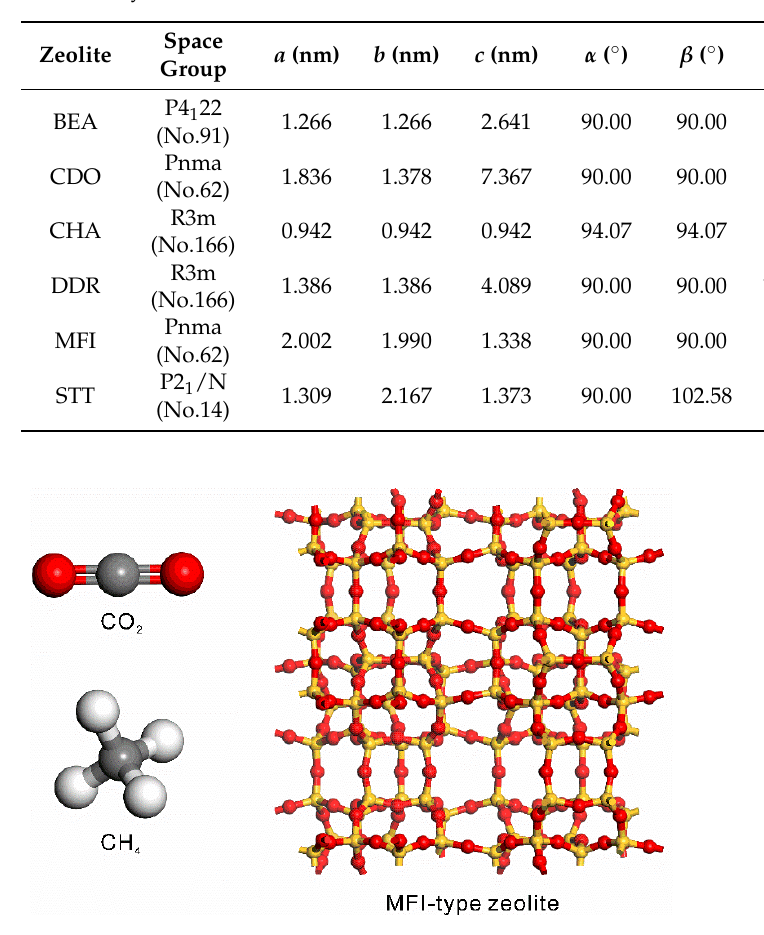
Table 1. Crystal structures of all-silica zeolites.